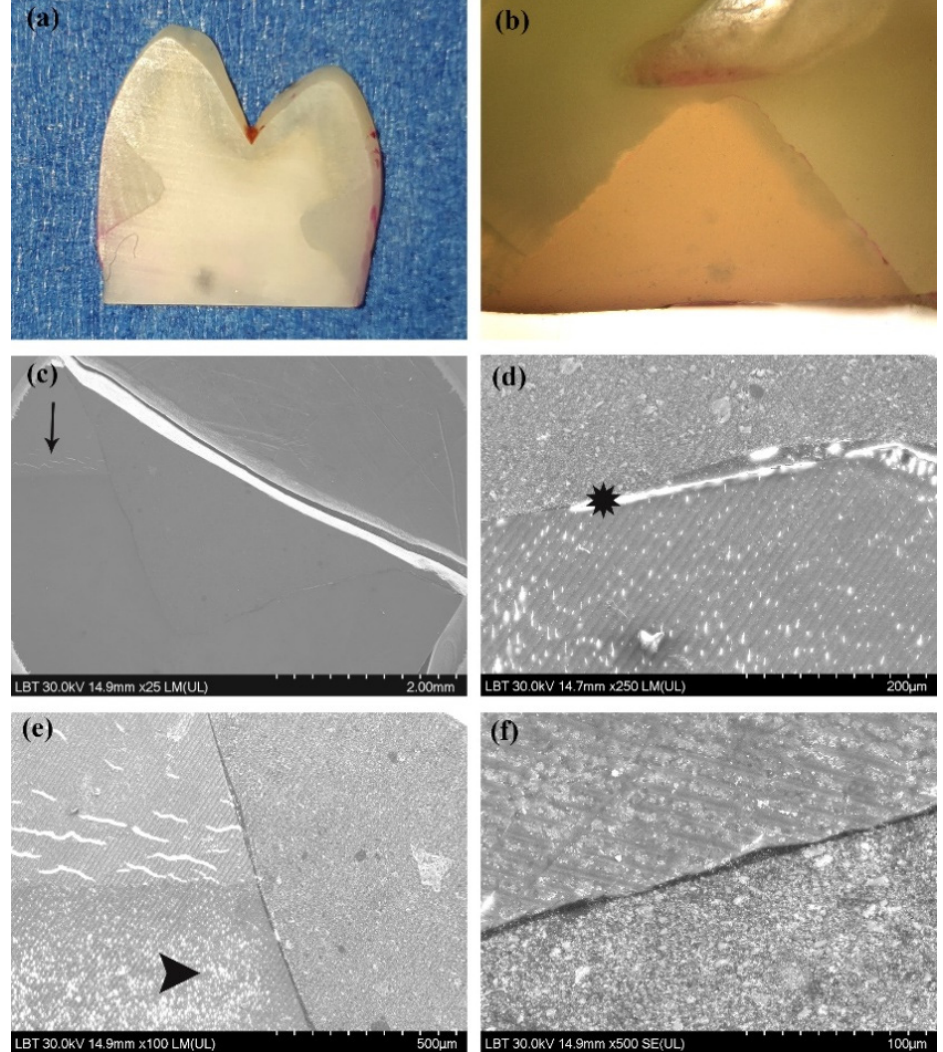
Figure 4. Beautiful Flow II Plus ® restoration. Good cervical adhesion of the cementum-located restoration on the tooth section (right) ( a ) and on optical microscopy ( b ). SEM overview of the same restoration with good cervical adhesion and some white fissures in the occlusal enamel (upper-left) (25 × ) ( c ). Random microleakage of the adhesive layer (250 × ) ( d ). Detailed fissures in occlusal enamel (upper left) (100 × ) ( e ). Continuous 5 µ m thick adhesive layer (500 × ) ( f ). black arrow = enamel fissures, asterisk = microleakage, arrowhead = dentin tubuli.